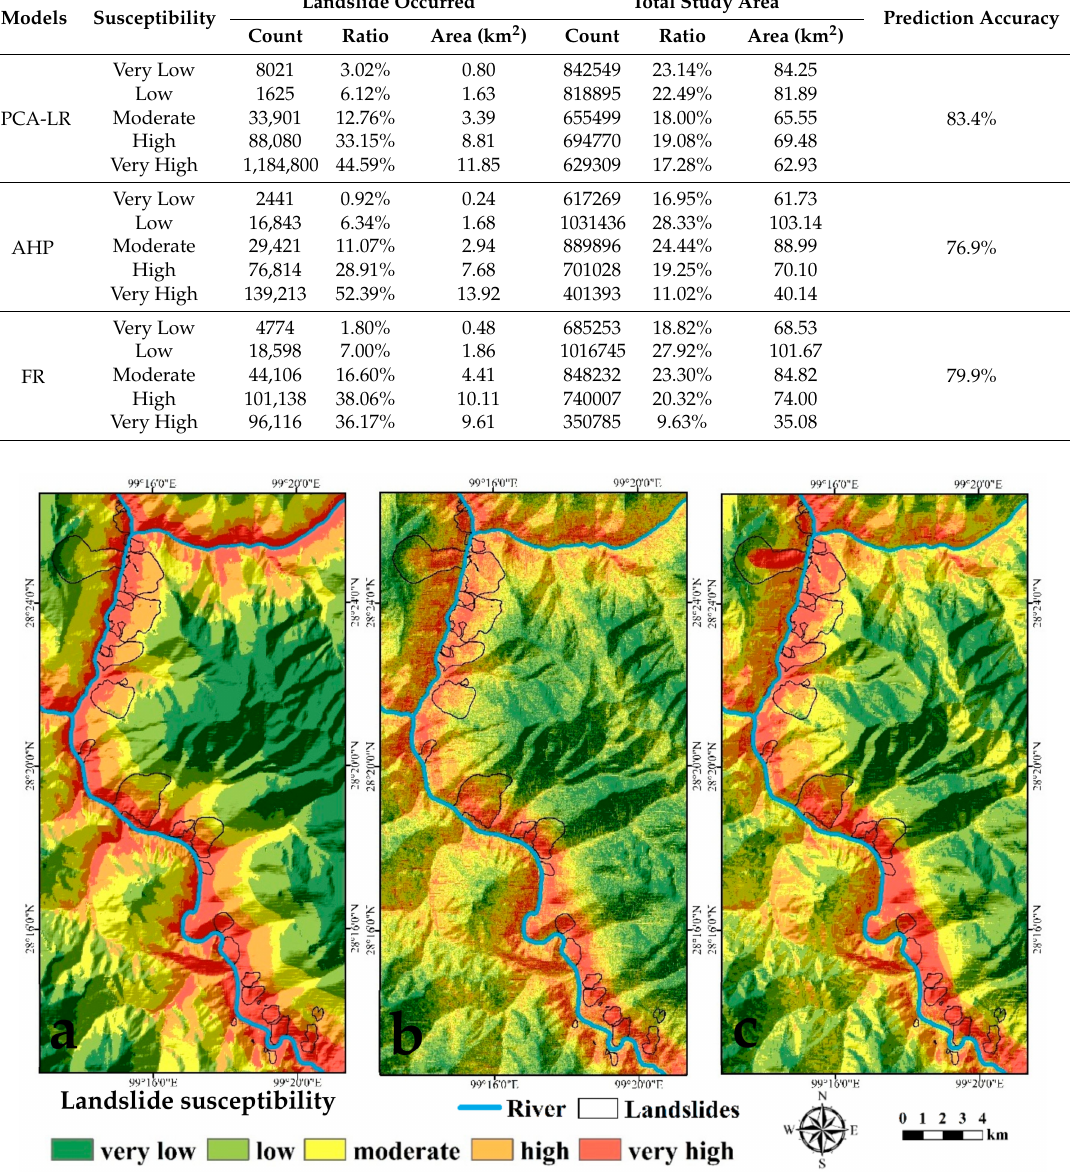
Figure 10. Landslide susceptibility map: ( a ) PCA-logistic regression (LR) method; ( b ) FR method; and ( c ) analytic hierarchy process (AHP)